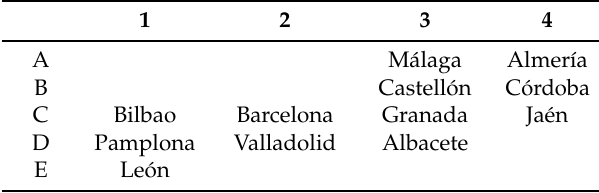
Table 3. Cities selected for the research and climatic severities.